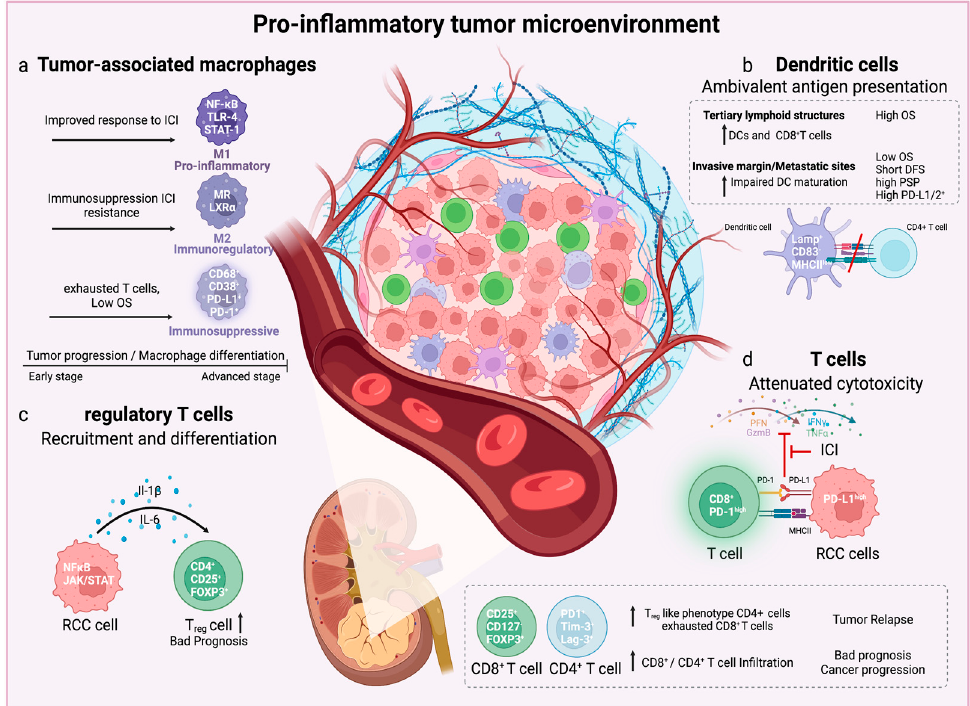
Figure 2. ( a ) Macrophages express a variety of markers, including pro-inflammatory, im- mune-regulatory, and suppressive markers. While M1 macrophages are responsible for the eradi- cation of pathogens and tumor cells, M2 macrophages have immune suppressive properties in- ducing an exhausted signature in CD8+ T cells as well as the tendency for tissue repair and tumor progression. ( b ) DCs with impaired maturation ((DC Lamp ; DC CD83- ; DC MHCII,Low ) are located outside of tumor-associated tertiary lymphoid structures (NTLS) of RCC tumors and are associated with high levels of PD-L1/PD-L2 and poor prognosis. ( c ) T reg cells reduce the cytotoxicity of effector T cells, thereby inducing immunosuppressive phenotype in RCC tumors. ( d ) RCC tumors